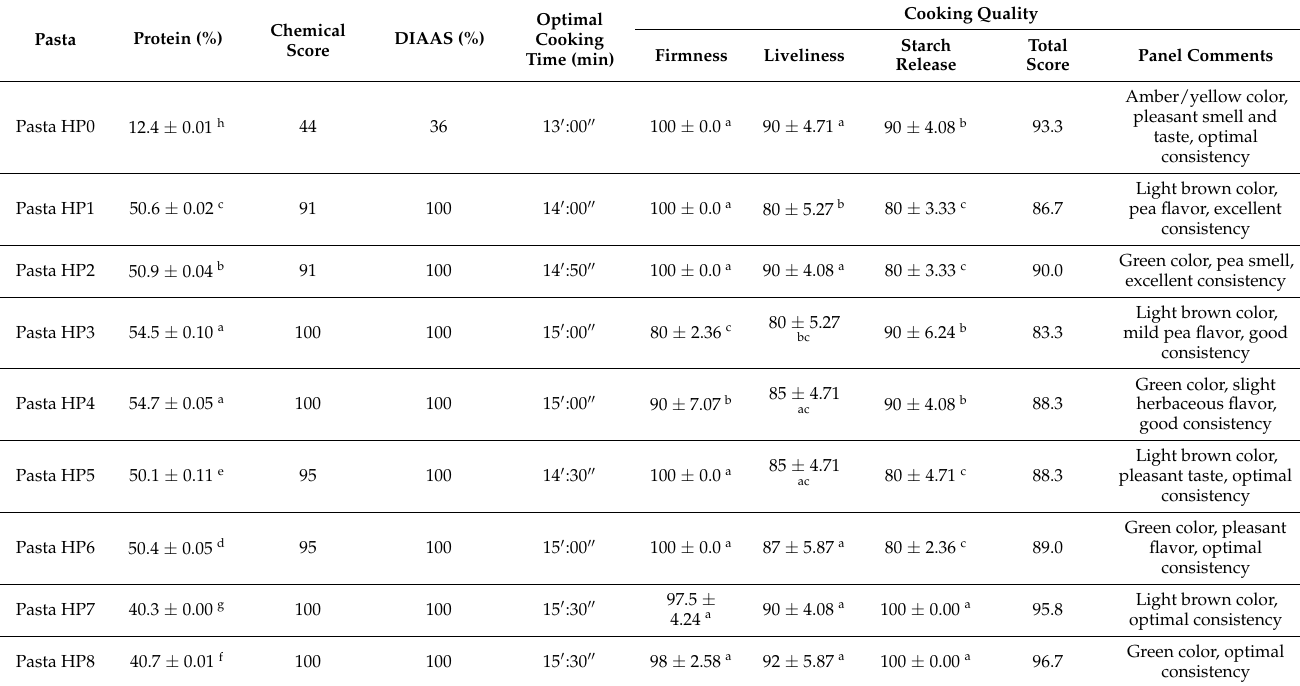
Table 7. Cooking quality of experimental high-protein pastas (Pasta